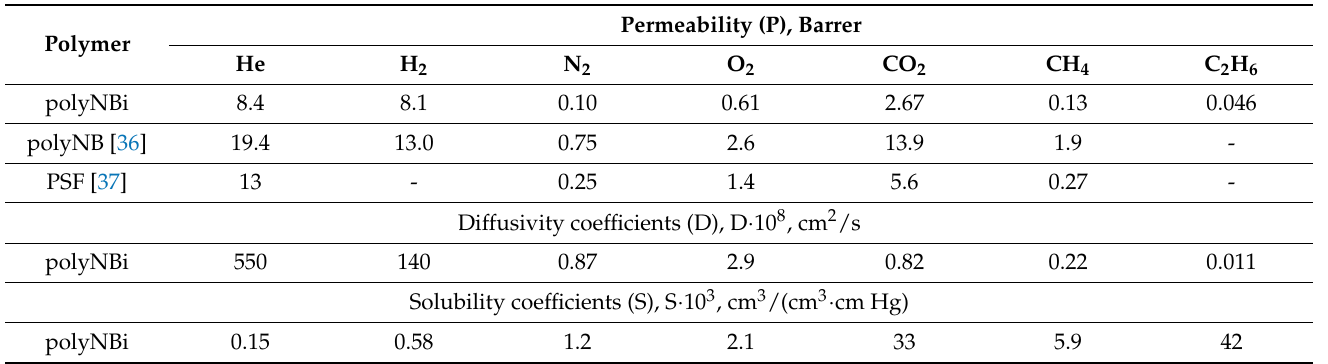
Table 3. Permeability, diffusivity, and solubility coefficients of various gases in polyNBi and polyNB. Permeability (P), Polymer